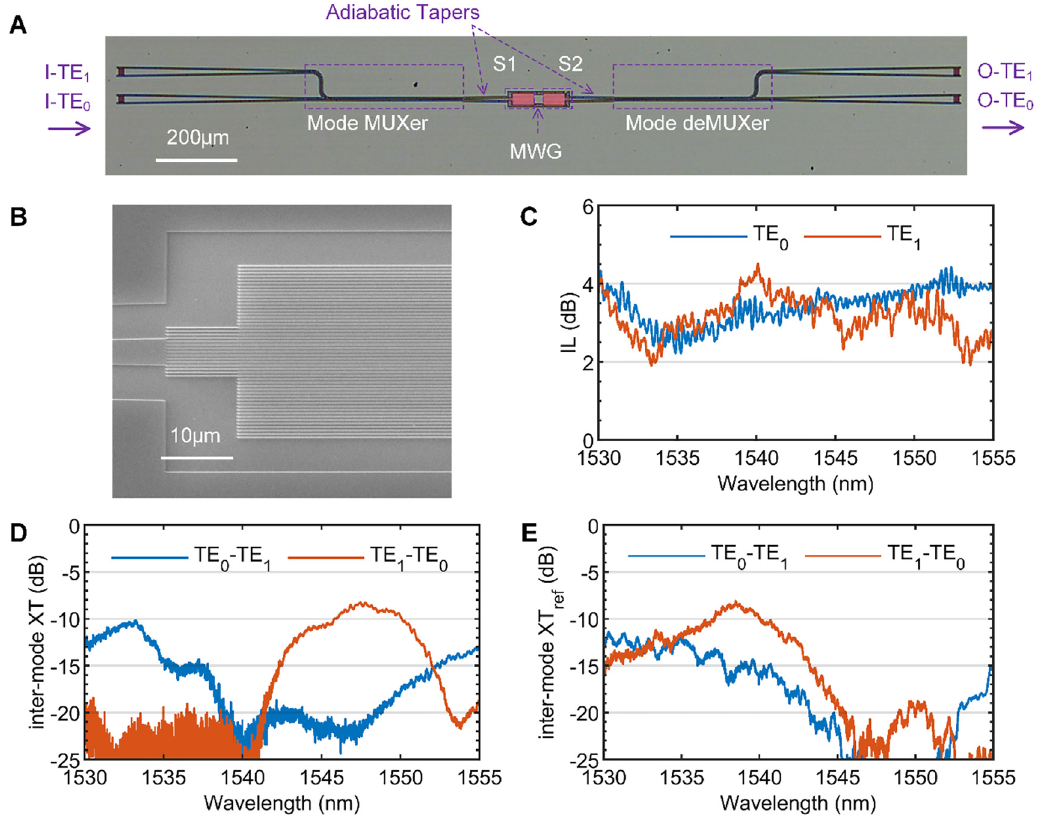
Figure 4: Device fabrication and characterization for the TE 0 and TE 1 modes. (A) Optical microscope image of the fabricated scheme. (B) SEM image of the GRINWG part. (C) Measured insertion loss spectra for TE 0 and TE 1 incident modes. (D) Measured intermode crosstalk spectra for TE 0 and TE 1 incident modes. (E) Measured intermode crosstalk spectra for TE 0 and TE 1 incident modes in the reference mode (de)MUXer link. GRINWG, graded-index waveguide; TE, transverse electric; SEM, scanning electron